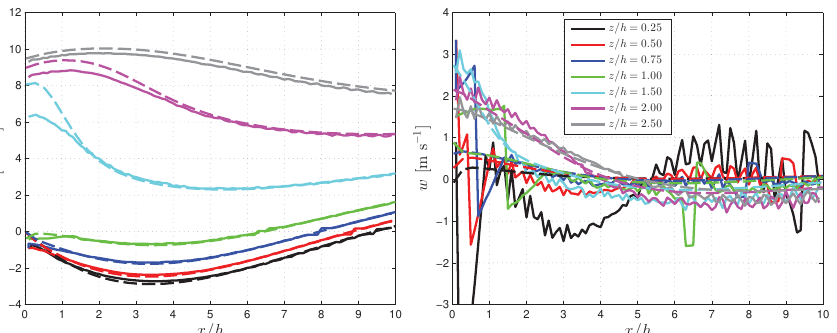
Figure 5. Simulation of the WS measurements (solid lines) and the CFD simulation results (dashed lines) for the u (left panel) and w com- ponents (right panel) and several vertical levels